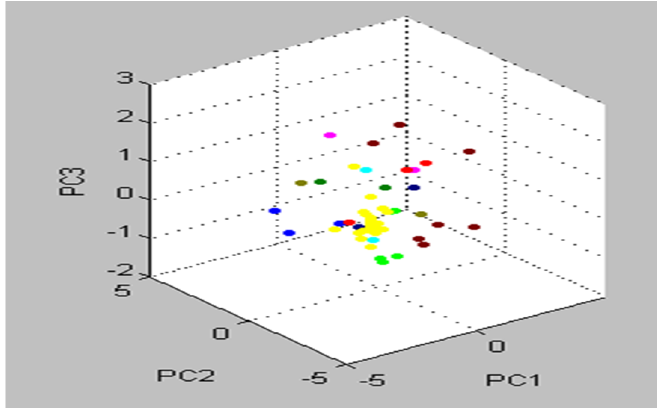
Figure 6. Almost all S. aureus strains were categorized as one group in the cluster view of the 3d PCA (strictly correlated and harmonized together).